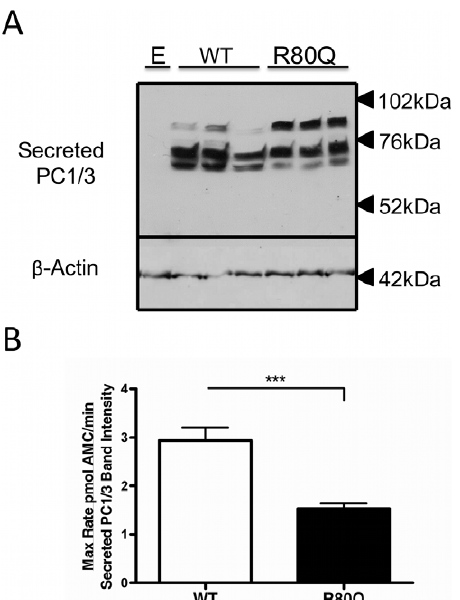
Figure 5. Western blotting of wild-type and novel R80Q (rs1799904) variant PC1/3s, expressed in Neuro-2A cells. Panel A: Neuro-2a cells were transiently transfected with equal amounts of empty pcDNA3 (E), or pcDNA3 encoding wild-type PC1/3 or the novel variant R80Q (rs1799904) PC1/3. Western blots of media were probed using amino-terminally directed PC1/3 primary antiserum. The data shown represent one of 3 independent experiments performed in triplicate. Panel B: Specific activities of wild-type PC1/3 and the R80Q PC1/3 variant. Enzymatic activities of secreted recombinant PC1/3 proteins in conditioned medium were compared by measuring maximum cleavage rates using the fluorogenic substrate pyr-ERTKR- amc during a 1 h kinetic assay. Three replicates per transfection condition were assayed in triplicate, and maximum rates were divided by band intensity of immunoreactive protein in the spent medium of the same wells from which the activity data were derived. Specific activity values are shown as the mean 6 S.D. Data represent one of 3 independent experiments, each performed in triplicate.